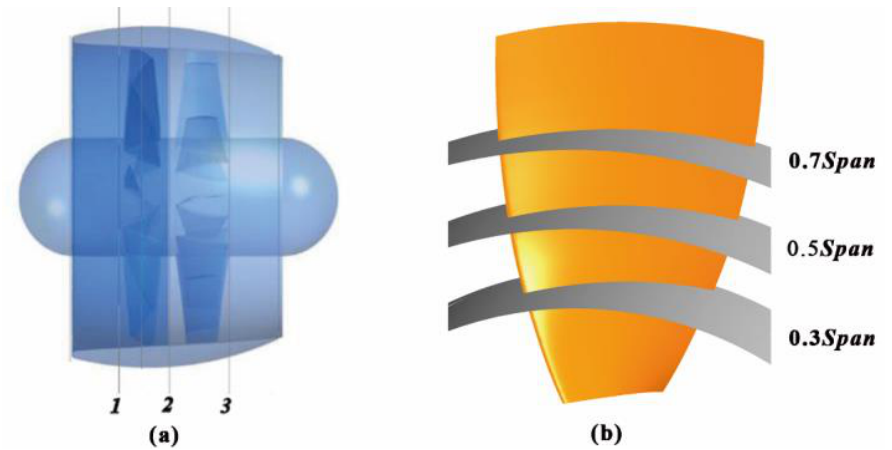
Figure 22. Schematic diagram of locations selected: ( a ) streamwise location and ( b ) span location.